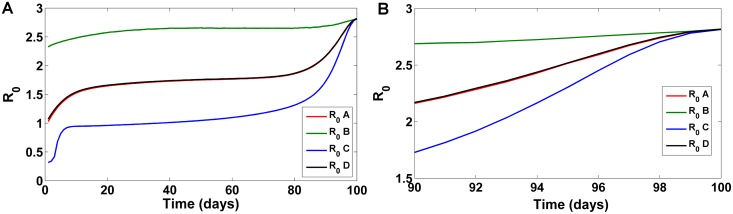
Effect of control strategies on R0.A) Comparison of R0 behavior for the four strategies B) Fig 6A magnified for t = 90–100 days.